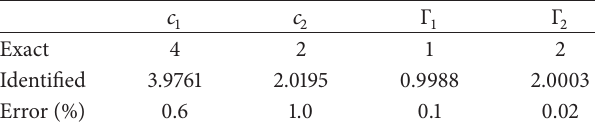
Figure 3: Illustration of zero-crossing times in the region of steady state. Table 1: Identified coefficients compared with the exact ones: steady-state